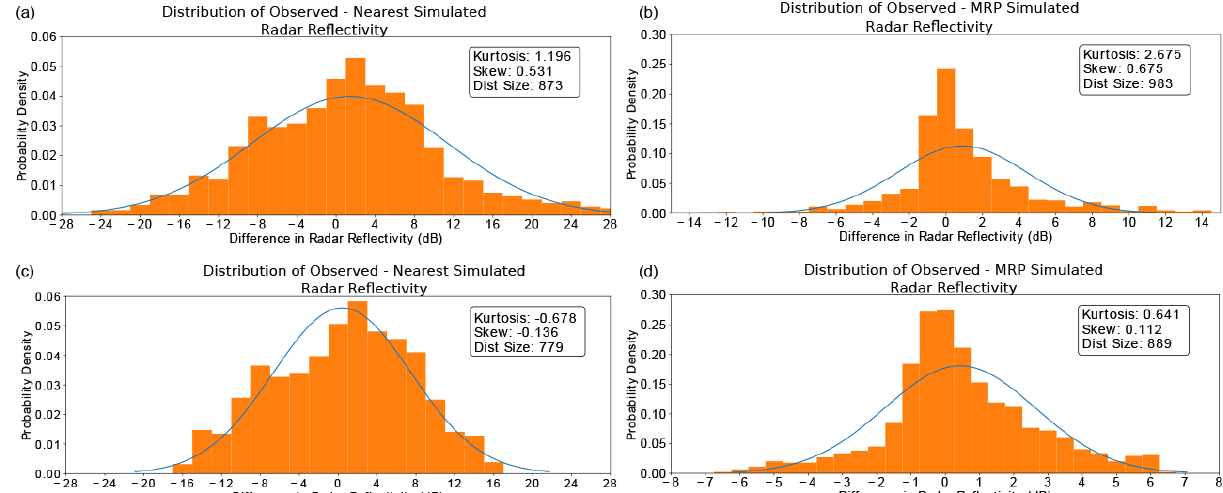
Figure 11. (a) – (d) Distribution of observed minus simulated reflectivity errors for the nearest corresponding profile when no data are excluded, the MRP when no data are excluded, the nearest corresponding profile when 10% of data are excluded, and the MRP when 10% of data are excluded. All distributions are shown at 80ma.g.l. for reflectivity innovations when there is signal both in the simulation and observation above the sensitivity threshold. The blue line shows the Gaussian distribution with the same mean and standard